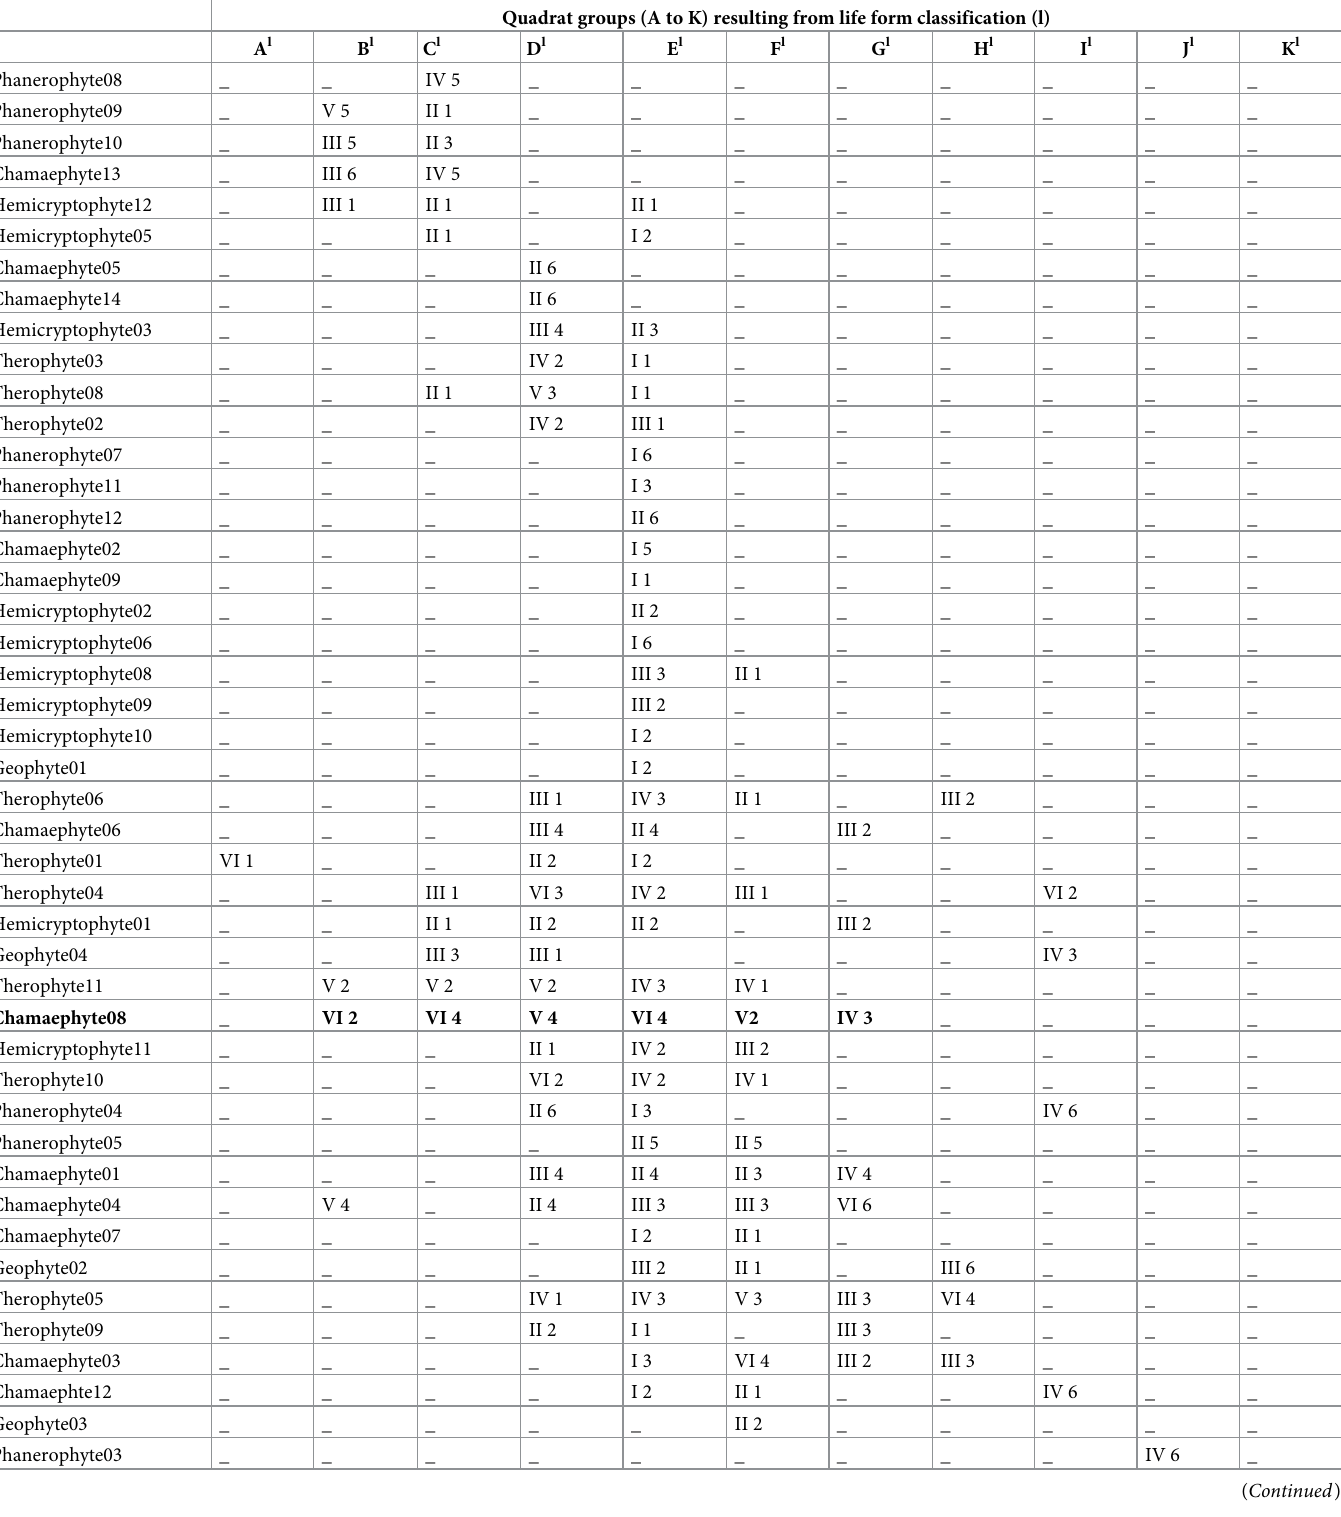
Table 1. TWINSPAN analysis of life form data set collected in Ras Beirut. (Alphabetical naming of quadrat groups by floristic and life form classification are not related.). Quadrat groups (A to K) resulting from life form classification